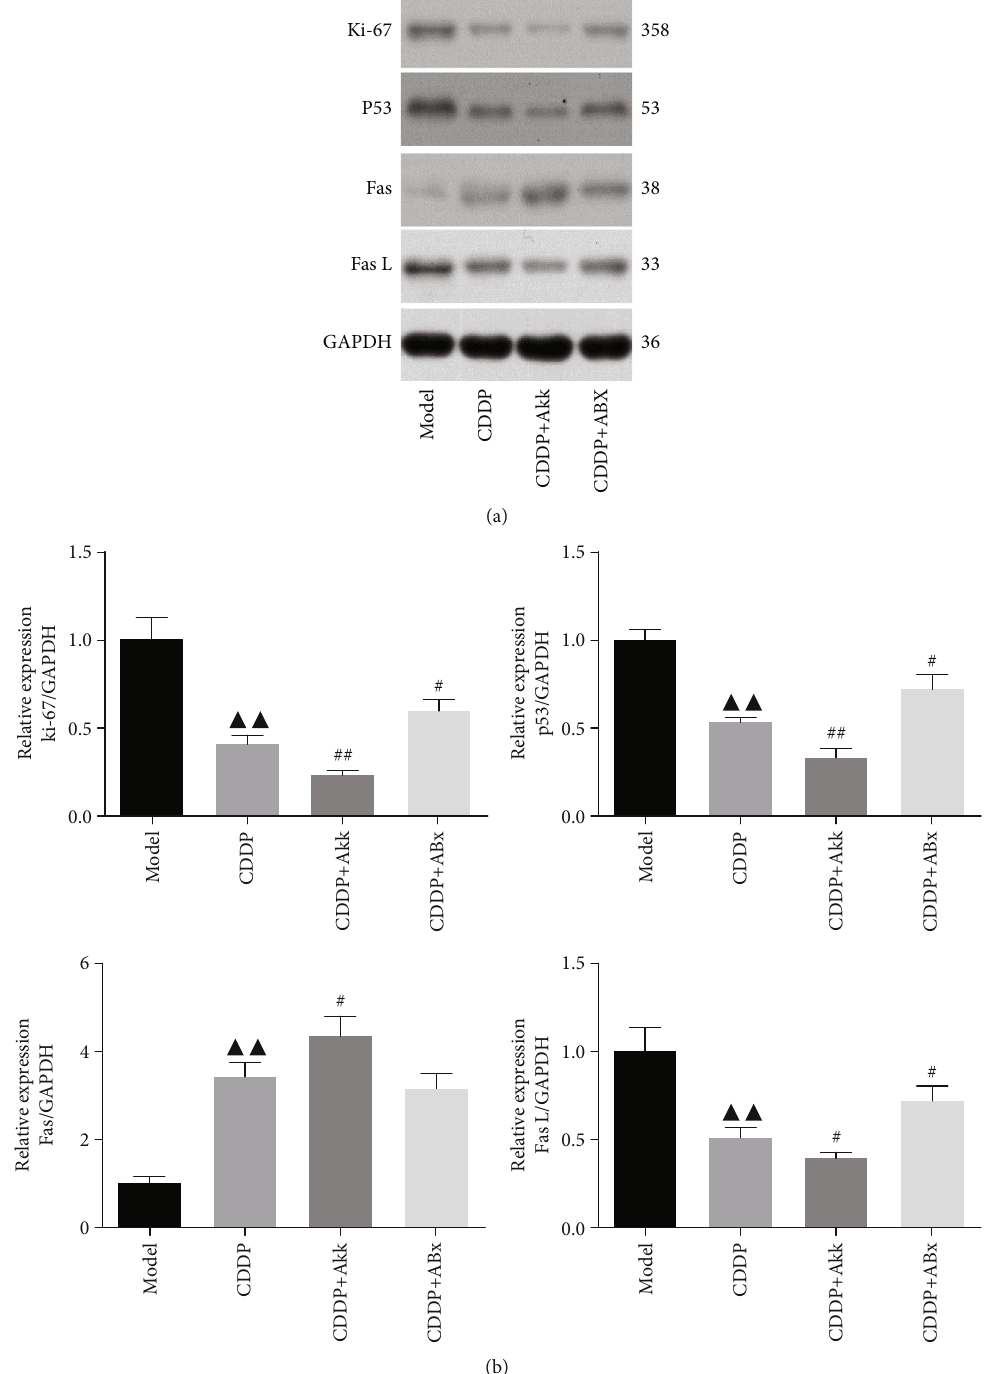
Figure 6: E ff ect of CDDP combined with Akk on ki-67, p53, Fas, and FasL protein expression in lung cancer mice. The levels of ki-67, p53, Fas, and FasL proteins from tumor tissues were detected by western blot and normalized to GAPDH (a), and then relative band intensities were used in order to quantify ki-67, p53, Fas, and FasL proteins (b). Data were presented as the mean ± SD , n = 6 in each group. ▲▲ P < 0 : 01 versus the model group; # P < 0 : 05 , ## P < 0 : 01 versus the CDDP +ABx group ( P < 0 : 01 ). In total T cells of the spleen, the The percentages of CD4 + CD25 + Foxp3 + Treg in the CDDP percentage change trend of CD4 + CD25 + Foxp3 + Treg cells in group were signi fi cantly higher than those in the CDDP +Akk group ( P < 0 : 05 ) and lower than those in the CDDP each group was the same as that in the peripheral blood group.